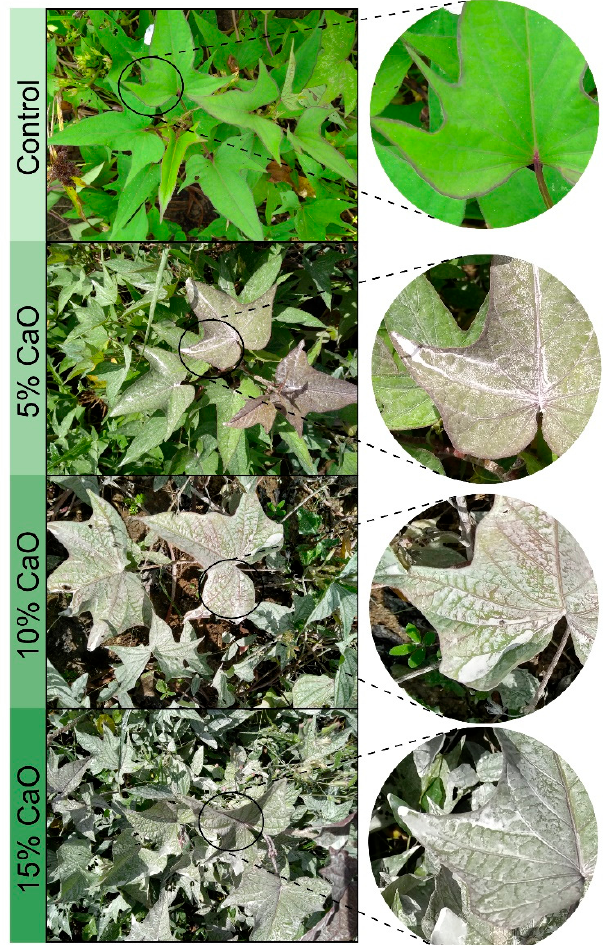
Figure 2. Leaves of sweet potato plants ( Ipomoea batatas L.) after applying calcium oxide (CaO) particle films at 5, 10, and 15% w/v and control (water).